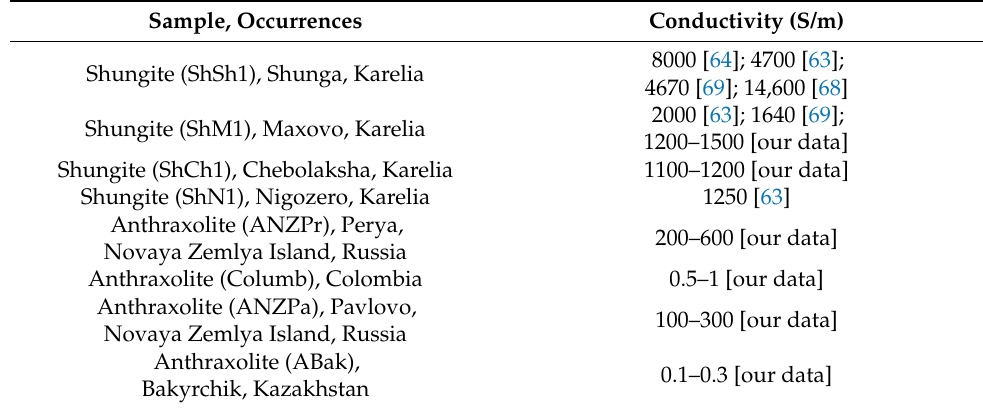
Table 1. Conductivity of some natural D sp 2 C disordered carbon